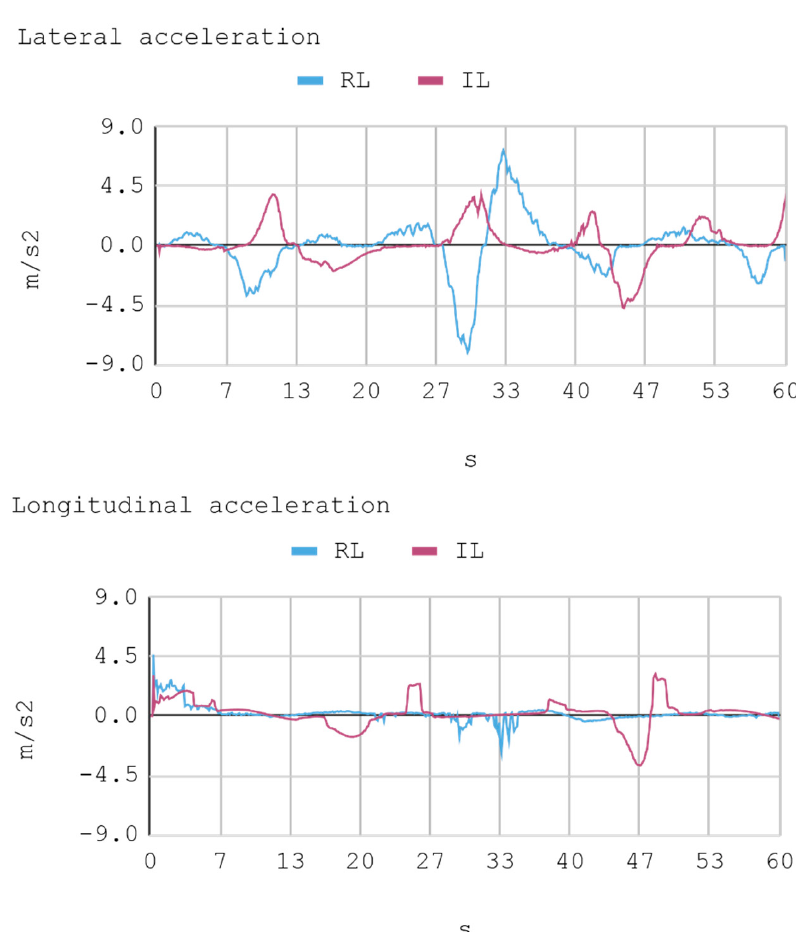
Figure 14. Case 2. Lateral and longitudinal acceleration of the automobile.